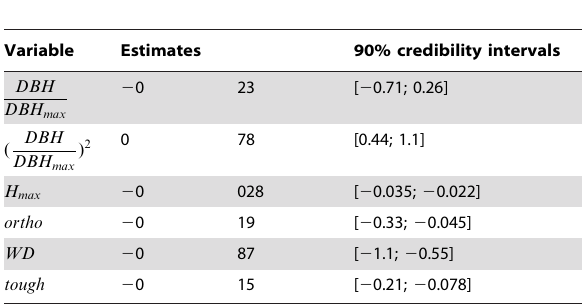
Table 2. Results of the Metropolis-Hastings algorithm for parameter estimation.